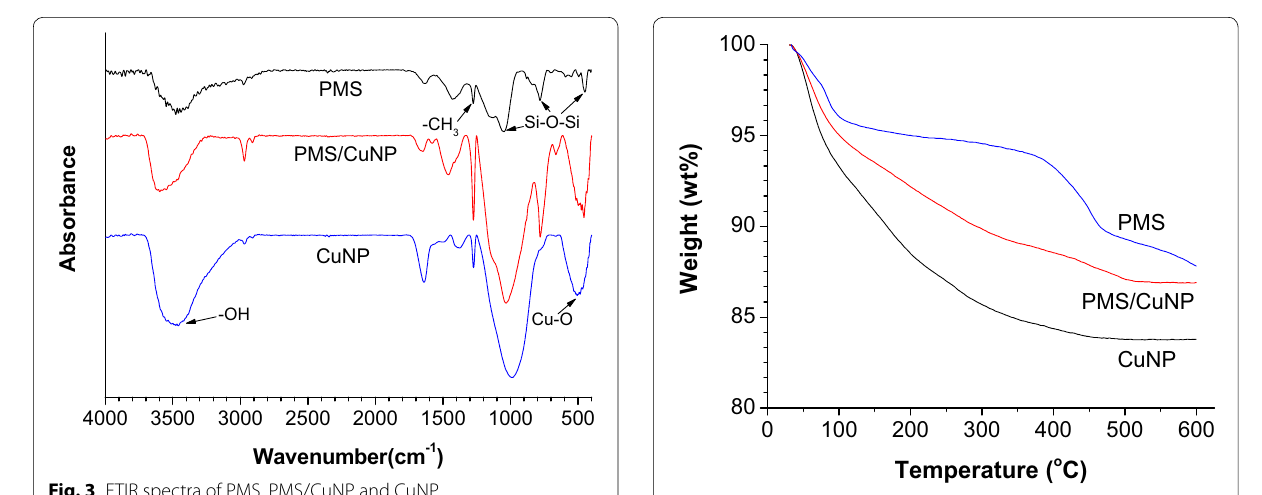
Fig. 4 TG spectra of PMS, PMS/CuNP and